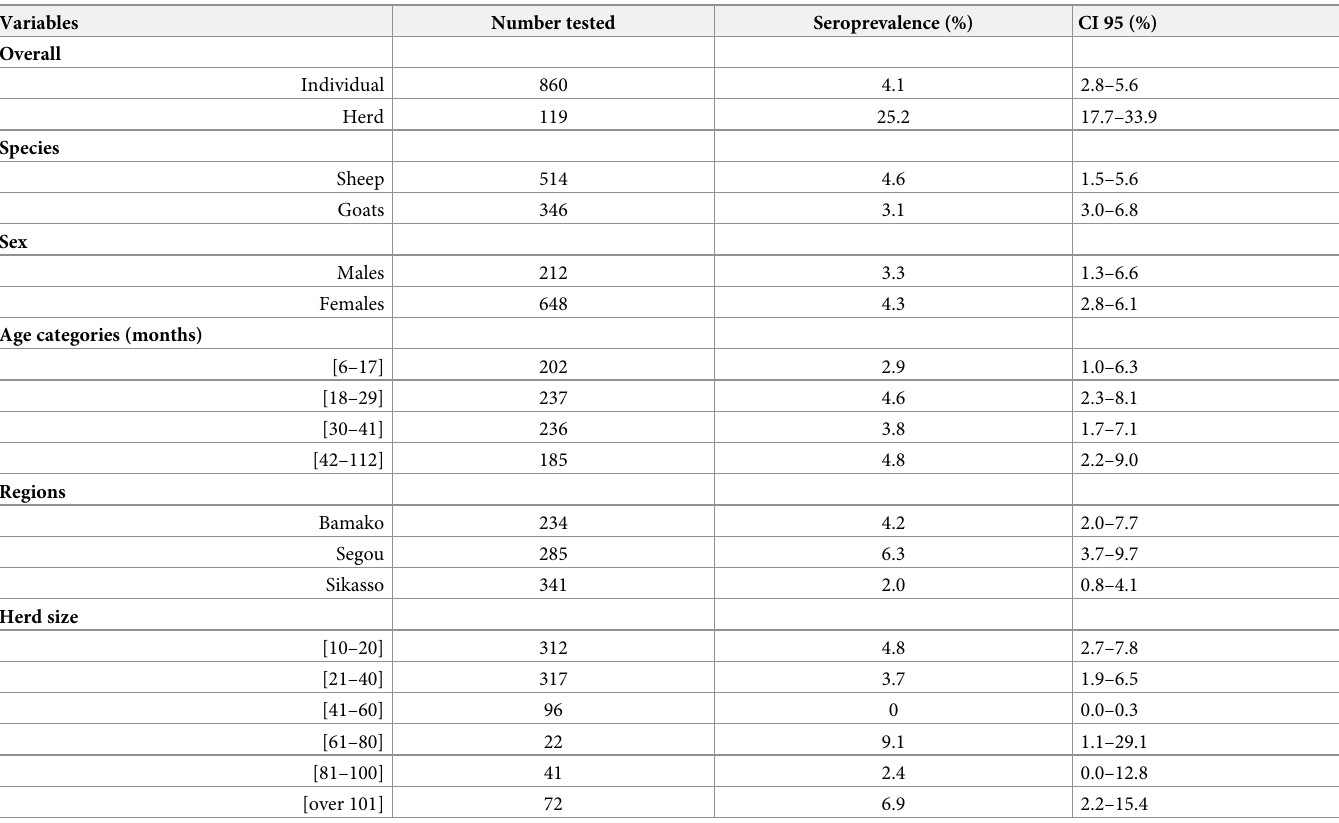
Table 2. Univariate association between brucellosis positivity and potential risk factors in goats and sheep (CI: Confidence interval). Variables